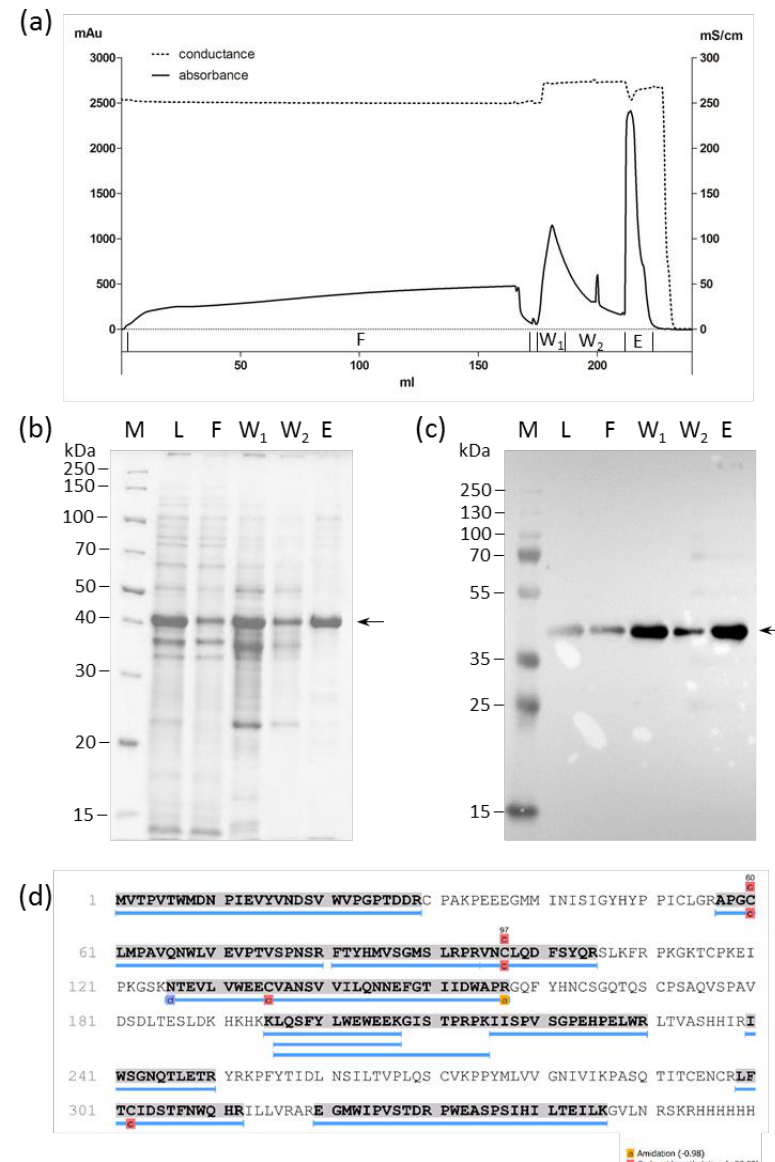
Figure 2. Purification of HERV-K18(SU) from bacterial inclusion bodies using nickel nitrilotriacetic acid (NTA) chromatography. ( a ) The chromatogram shows absorbance at 280 nm and electric conduction, as well as the fractions collected during the purification process (F: flow through; W1 and W2: wash with 25 mM imidazole; E: elution with 250 mM imidazole). ( b ) Coomassie brilliant blue- stained SDS-PAGE of the load (L) and the fractions depicted in ( a ). M: protein ladder. ( c ) Anti-His6 Western blot of the load (L) and the fractions depicted in ( a ). M: molecular weight marker standard. Arrows point to the target protein. ( d ) Mass spectrometric analysis of the elution fraction. The protein band corresponding to the target protein was excised from the polyacrylamide gel in the elution fraction, trypsin-digested and analyzed with mass spectrometry for matches (blue lines) with the template sequence. The sequence coverage was 55%.